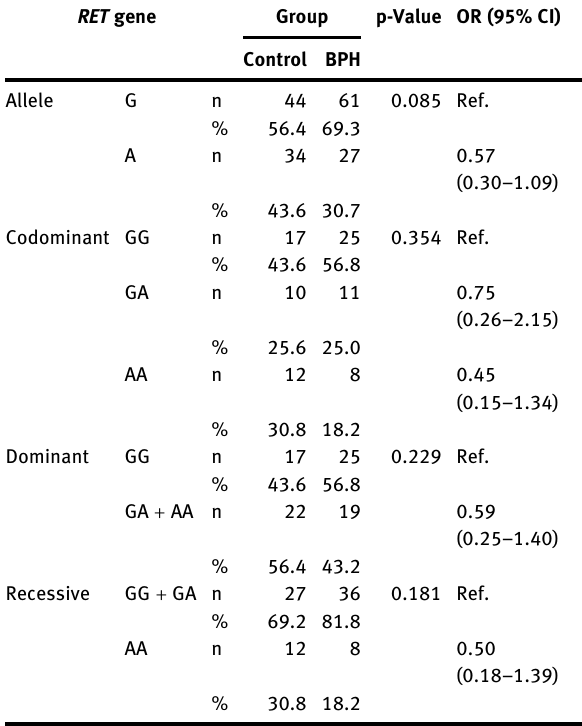
Table  : Single nucleotide polymorphism recorded in the RET gene (rs  ). RET